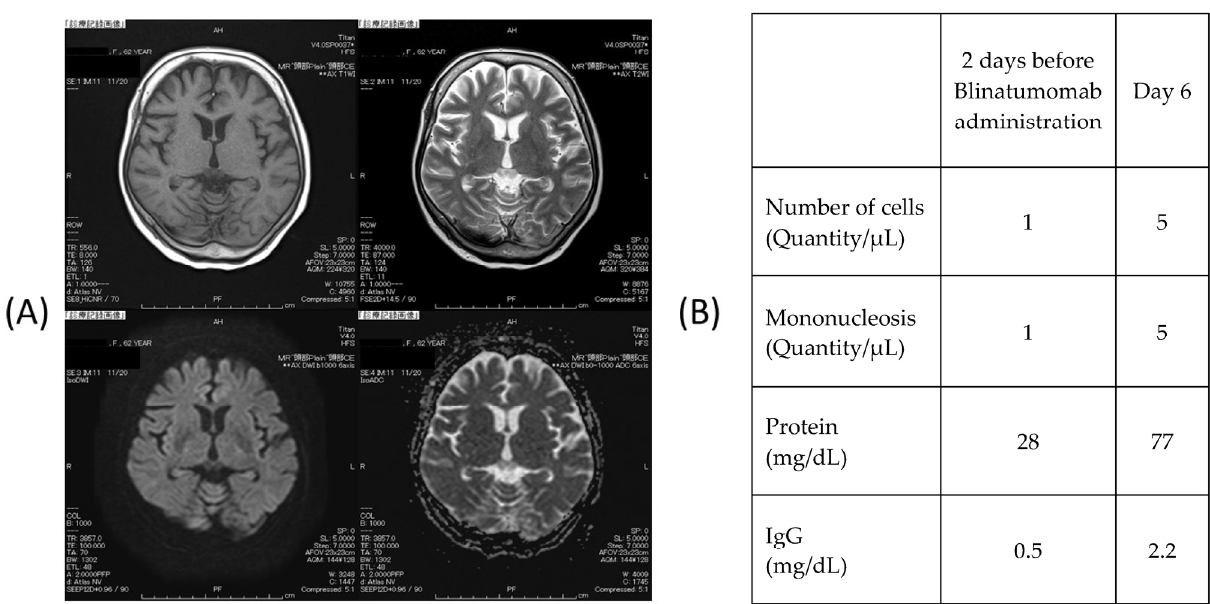
Figure 3. ( A ) Head magnetic resonance imaging. Findings: There is no obvious abnormal signal area in the brain parenchyma. There was no abnormal contrast area in the Gd. The pituitary gland was normal in size. The high T1WI signal in the posterior lobe was also maintained. ( B ) Cerebrospinal fluid test. The spinal fluid examination showed an increase in cerebrospinal fluid protein, so it is possible that some kind of encephalitis or meningitis had occurred, although it was not diagnosed. A blood test administered 2 days after the appearance of dysgraphia did not reveal any specific changes (Table 1). Table 1. A blood test was conducted 2 days after the appearance of dysgraphia. The blood tests revealed no obvious changes.